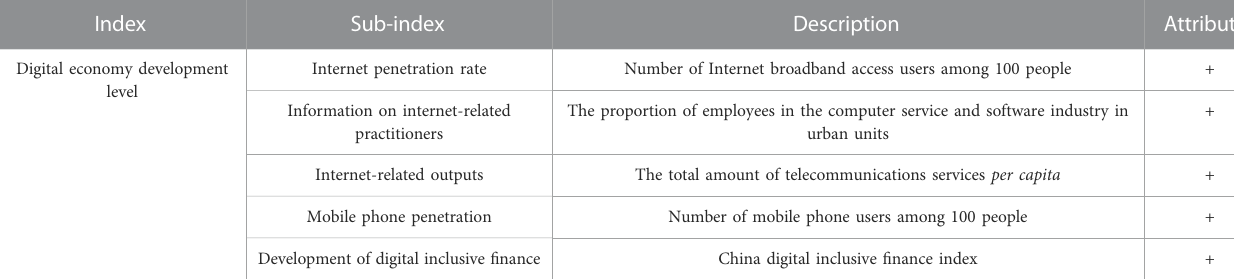
TABLE 2 System of digital economy development level